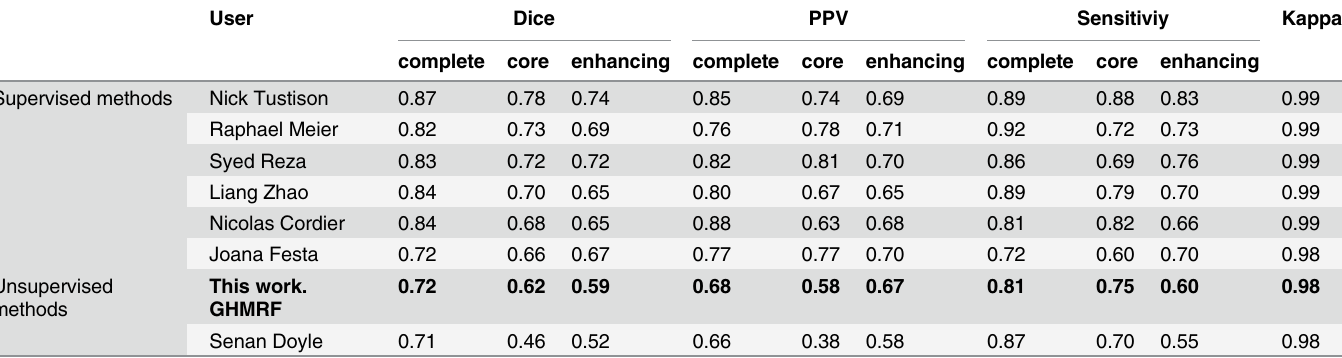
Table 3. Ranking of the BRATS 2013 Test set and the position occupied by our proposed unsupervised segmentation framework with the GHMRF algorithm. User Dice PPV Sensitiviy Kappa